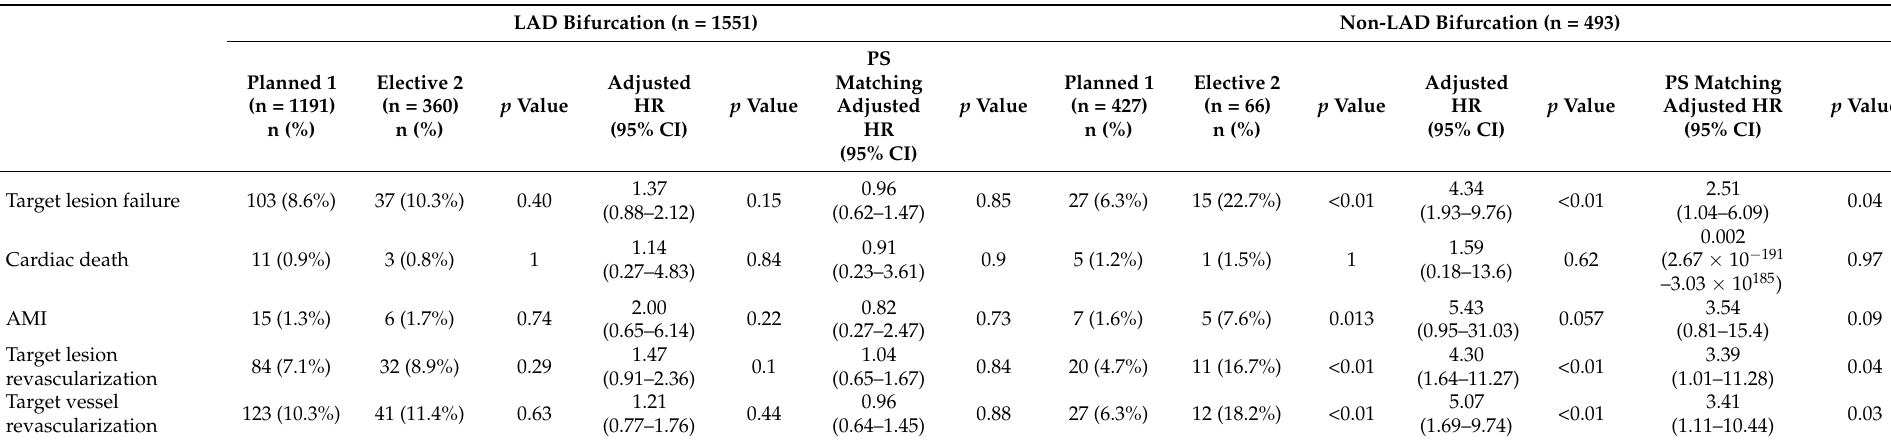
Table 3. Outcomes and hazard ratio for clinical outcomes according to location of bifurcation lesions and stenting strategies. LAD Bifurcation (n = 1551) Non-LAD Bifurcation (n =